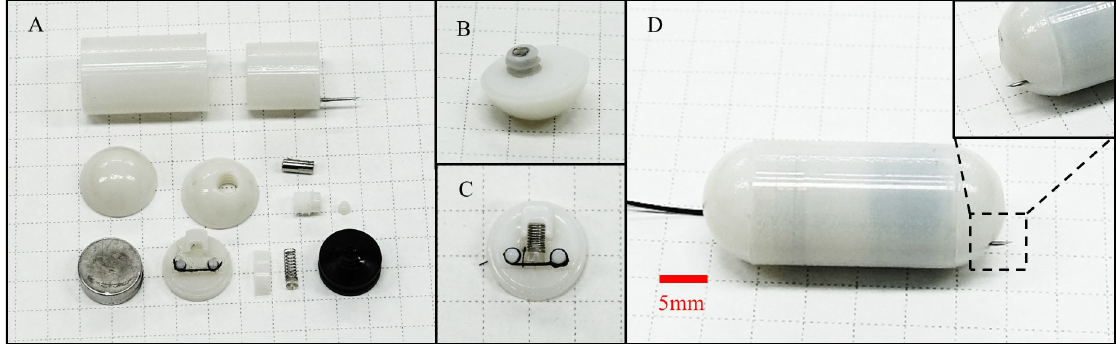
Fig 8. TCE fabrication. (A) Components of the TCE. (B) Assembled NCM. (C) Assembled triggering module. (D) Assembled TCE